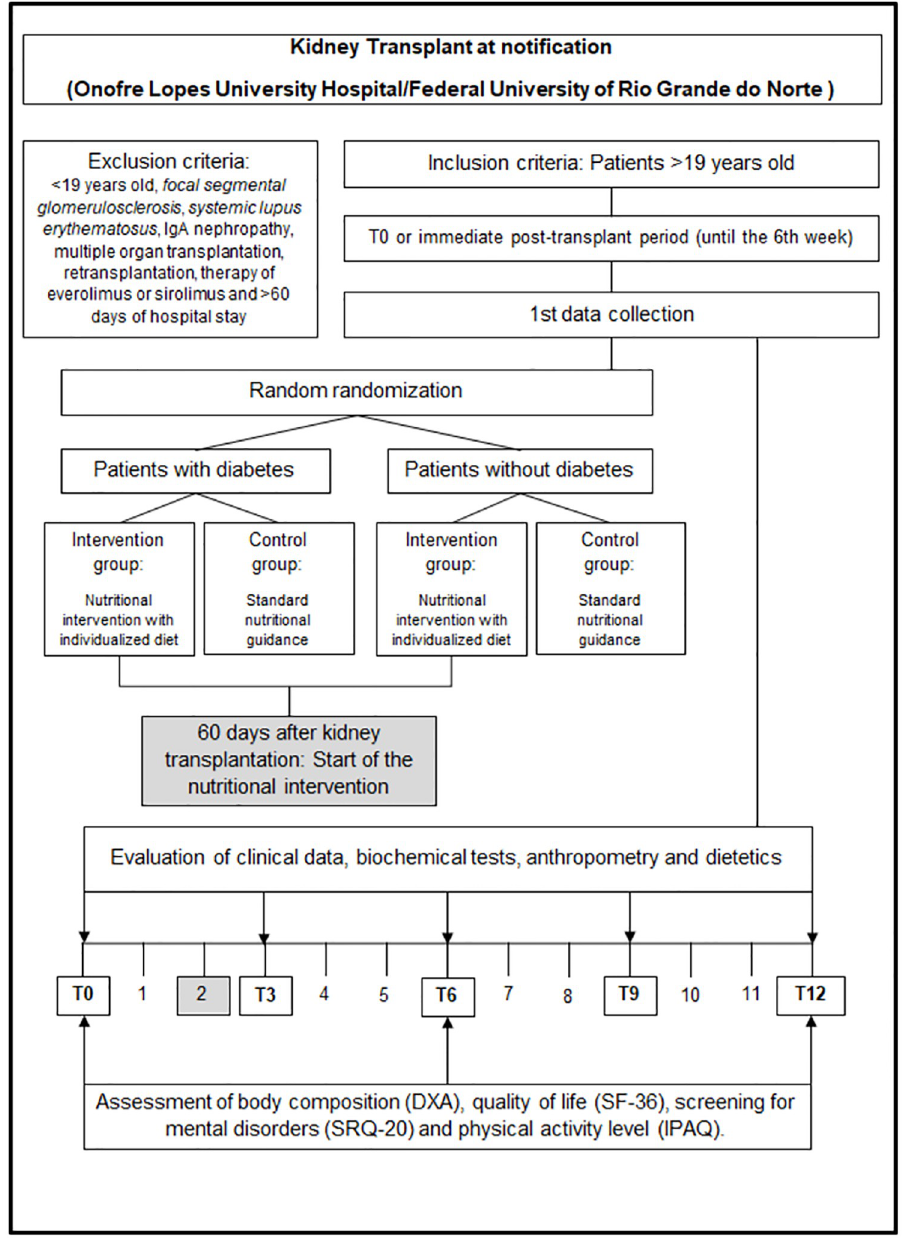
36-Item Short-Form Health Survey ; SRQ-20, Self-Reporting Questionnaire ; IPAQ, International Physical Activity Questionnaire